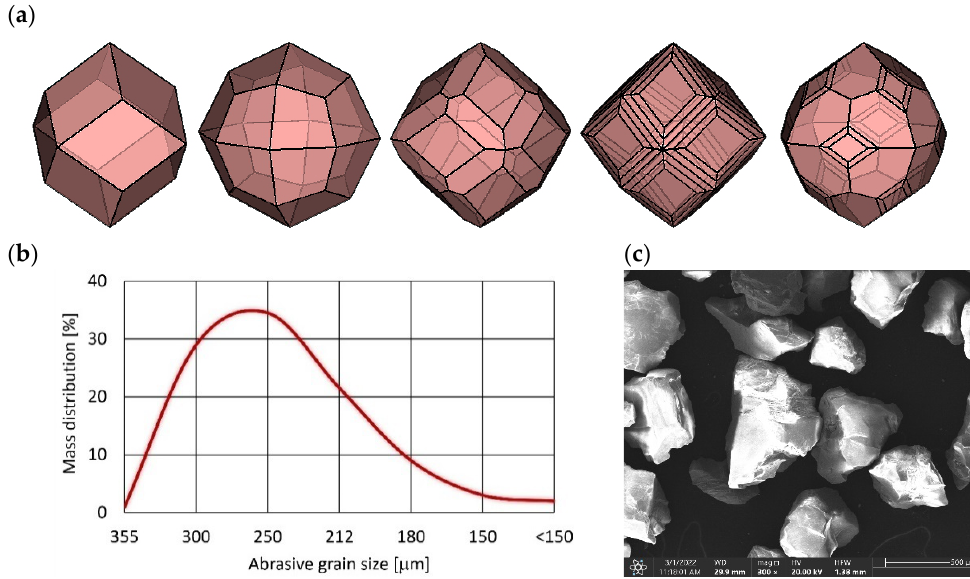
Figure 2. The J80A garnet abrasive: ( a ) the crystal shapes, ( b ) the grain size distribution, ( c ) the sample view of the grains.